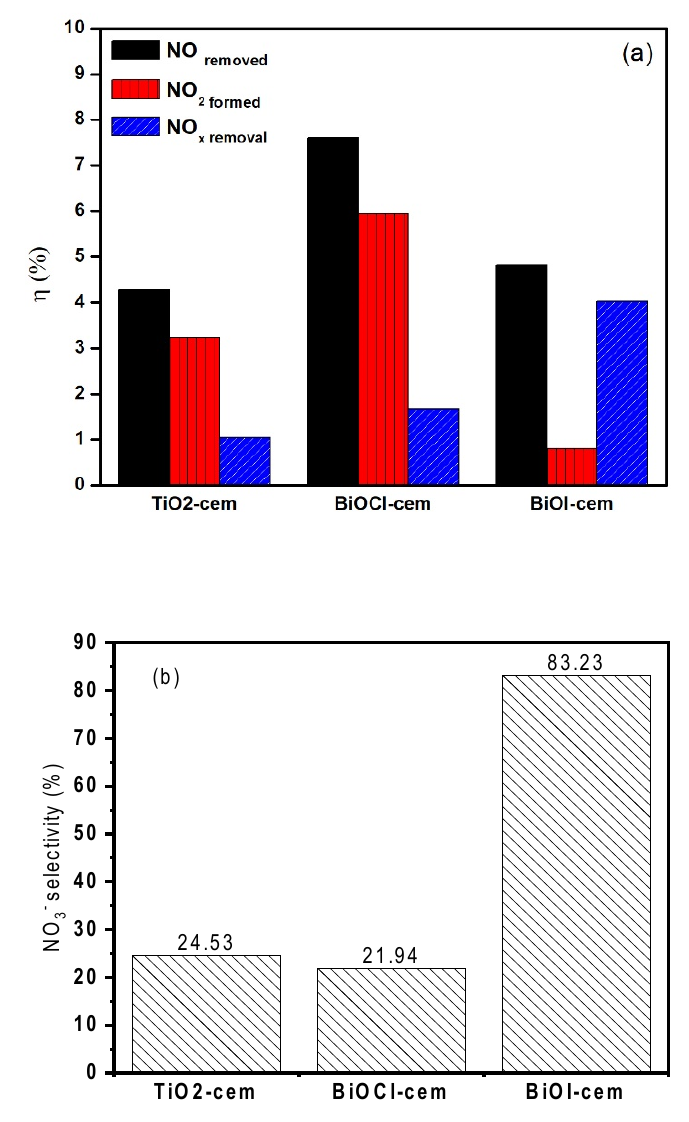
Figure 13. ( a ) NO-NO x removed and NO 2 formed efficiency (%) and ( b ) nitrate selectivity of photocatalyst/cement composites.